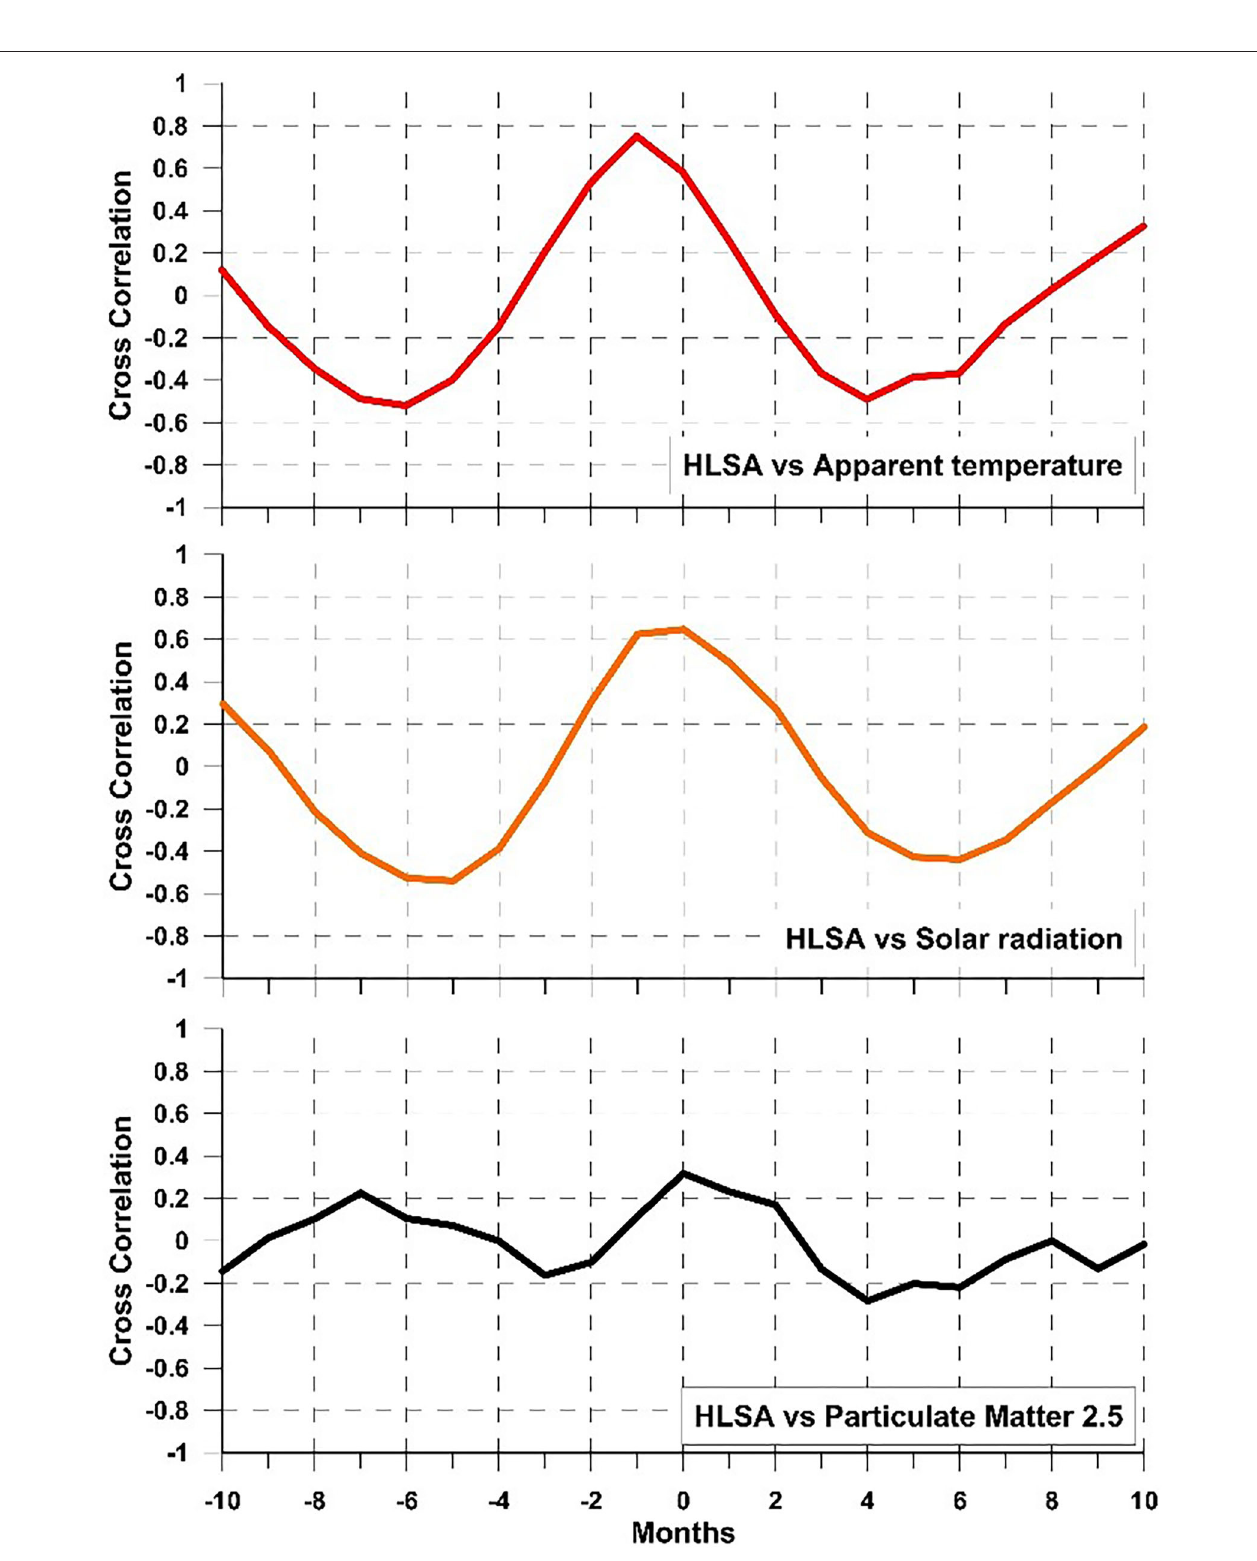
FIGURE 3 | Cross-correlation results: HLSA vs. apparent temperature (red); HLSA vs. solar radiation (orange); HLSA vs. PM 2.5 (black).